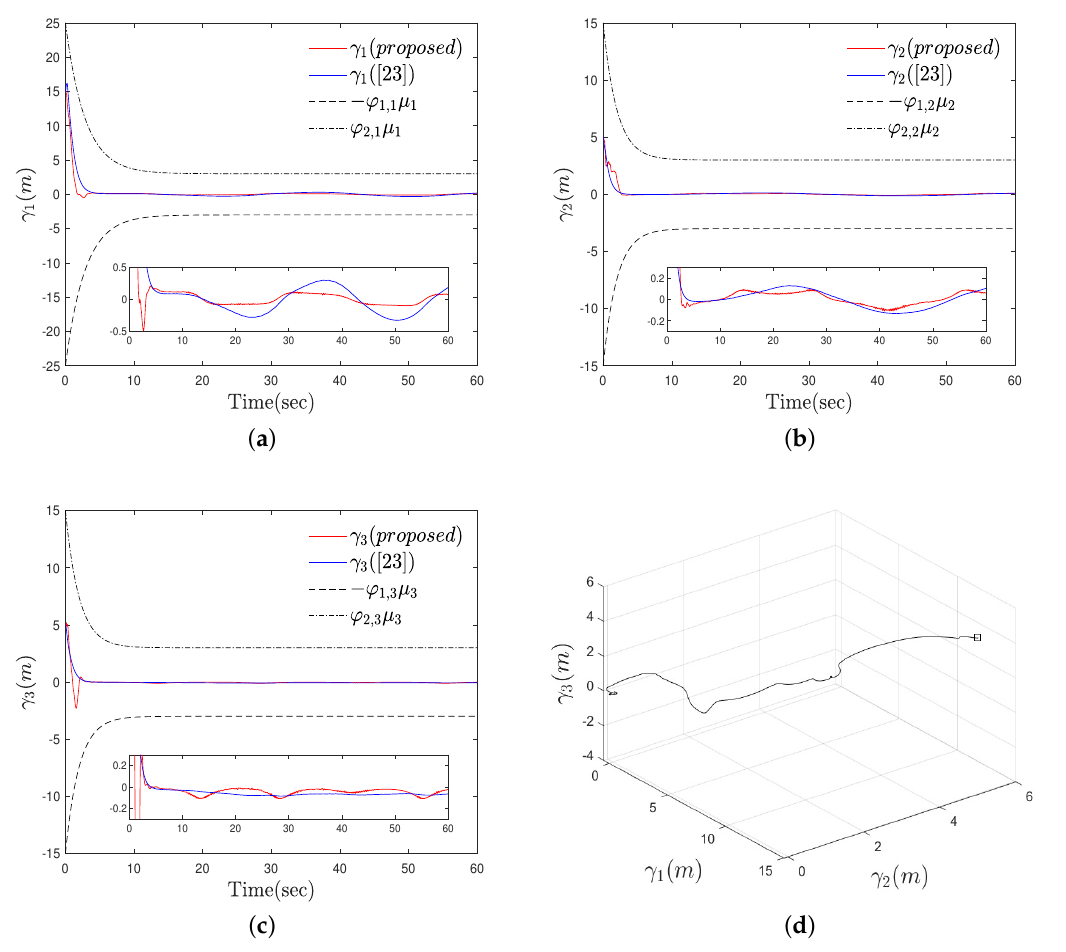
Figure 3. Tracking errors and error phase portraits of the proposed approach for Scenario 1 ( a ) comparison of γ 1 of the proposed approach and the previous approach [23] ( b ) comparison of γ 2 of the proposed approach and the previous approach [23] ( c ) comparison of γ 3 of the proposed approach and the previous approach [23] ( d ) phase portrait of γ 1 , γ 2 , and γ 3 of the proposed